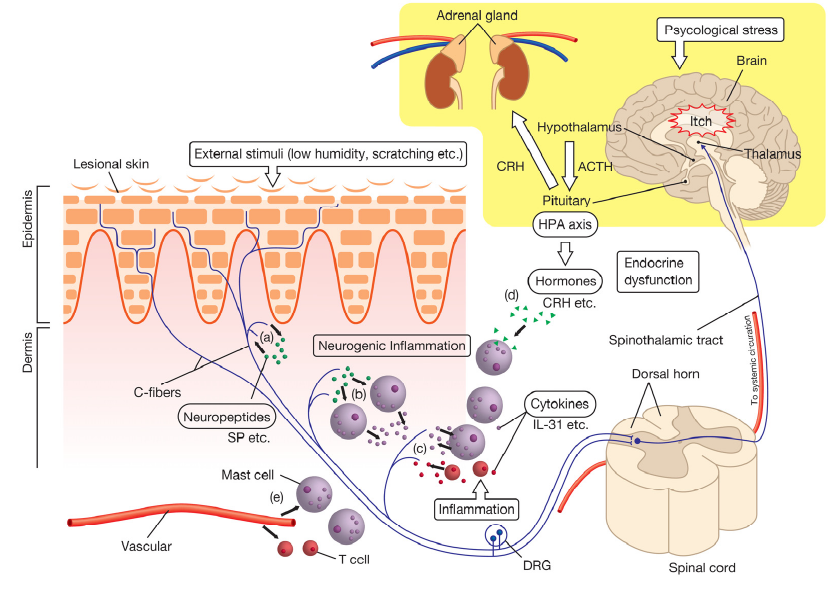
Figure 1. Mechanisms from the triggering to sensing of itch in psoriasis. Itch in psoriasis is triggered or exacerbated by external stimuli, lesional inflammation, and psychological stress. External stimuli, such as scratching behavior, promote the secretion of neuropeptides from nerve endings (axon reflex). Neuropeptides act on C-fiber neurons both ( a ) directly (by acting retrogradely on neurons) and ( b ) indirectly (via neurogenic inflammation) to convey itch signals to the central nervous system (spinal cord and brain). In lesional skin, ( c ) various immune cells, such as mast cells or T cells, secrete a number of cytokines, which mainly aggravate itch by enhancing inflammatory responses, such as mast cell degranulation. Some of these responses also elicit itch by directly acting on nerve endings. In addition, the HPA axis, which is stimulated by psychological stress